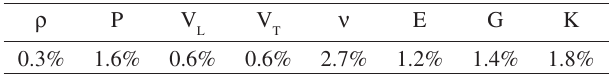
Table 2. Coefficient of variation of the measured bulk density ( ρ ), volume fraction porosity (P), longitudinal (V ( ν ), Young’s (E), shear (G), and bulk (K) modulus.